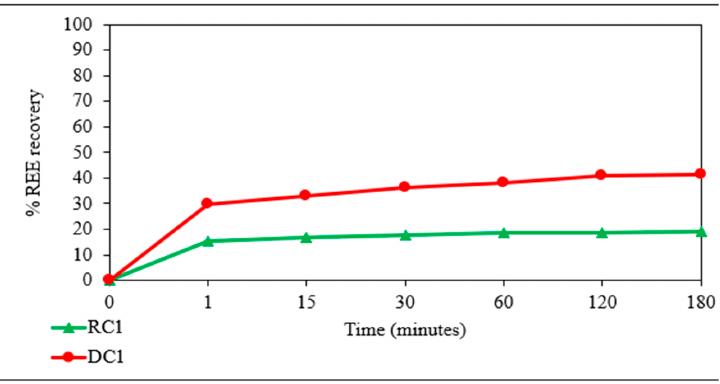
Figure 5. RC1 and DC1 % REE leaching recovery under the optimised leaching parameters (HCl concentration of 2 M, solid:liquid ratio of 10 g/L, leaching temperature of 50 °C, D 90 = − 106 μ m, stirrer speed 550 rpm).